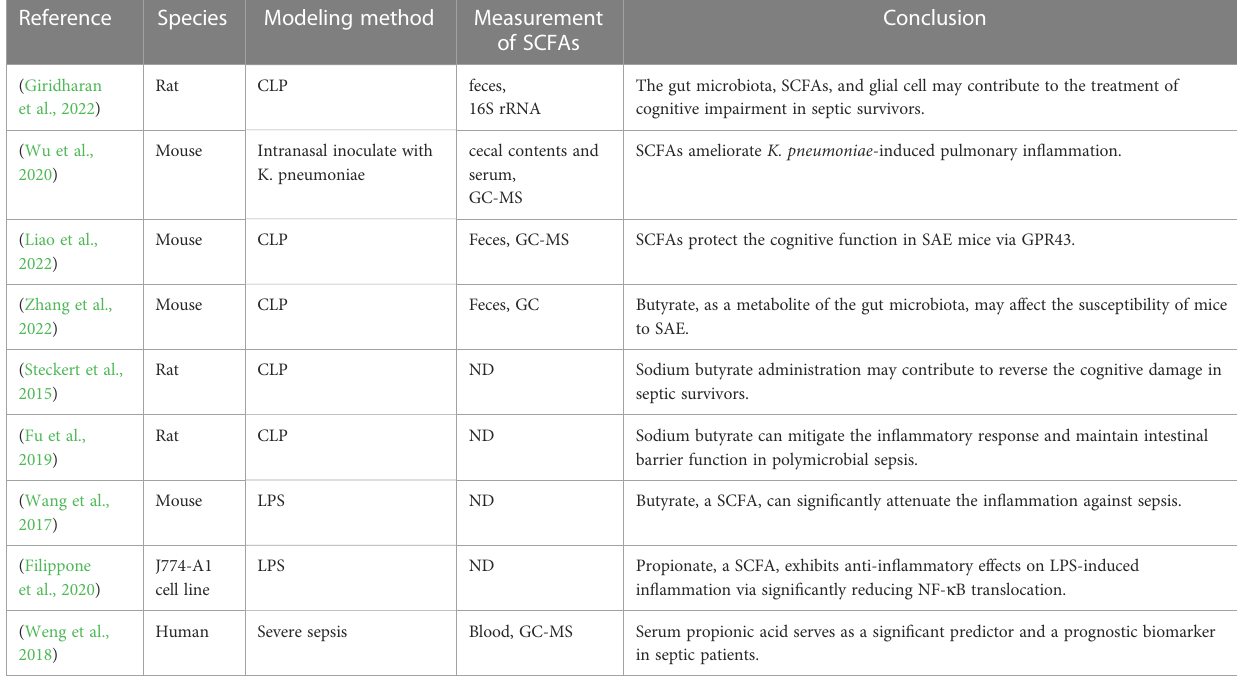
TABLE 1 Overview of the application background of SCFAs to sepsis